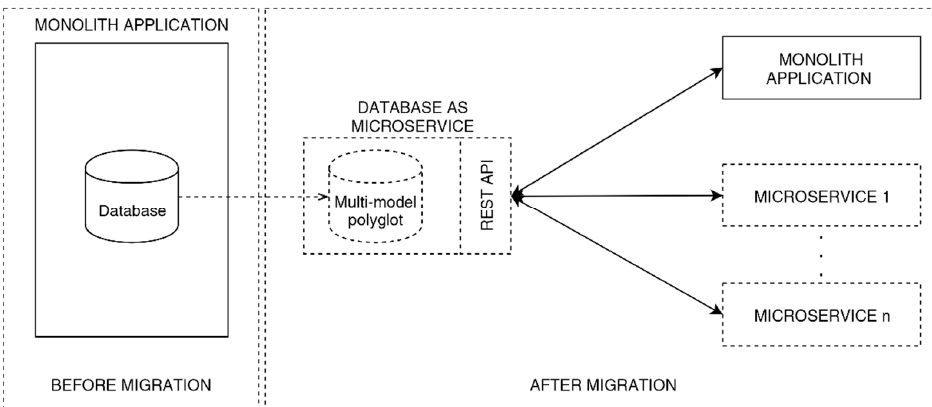
Figure 1. The purpose of the proposed approach.